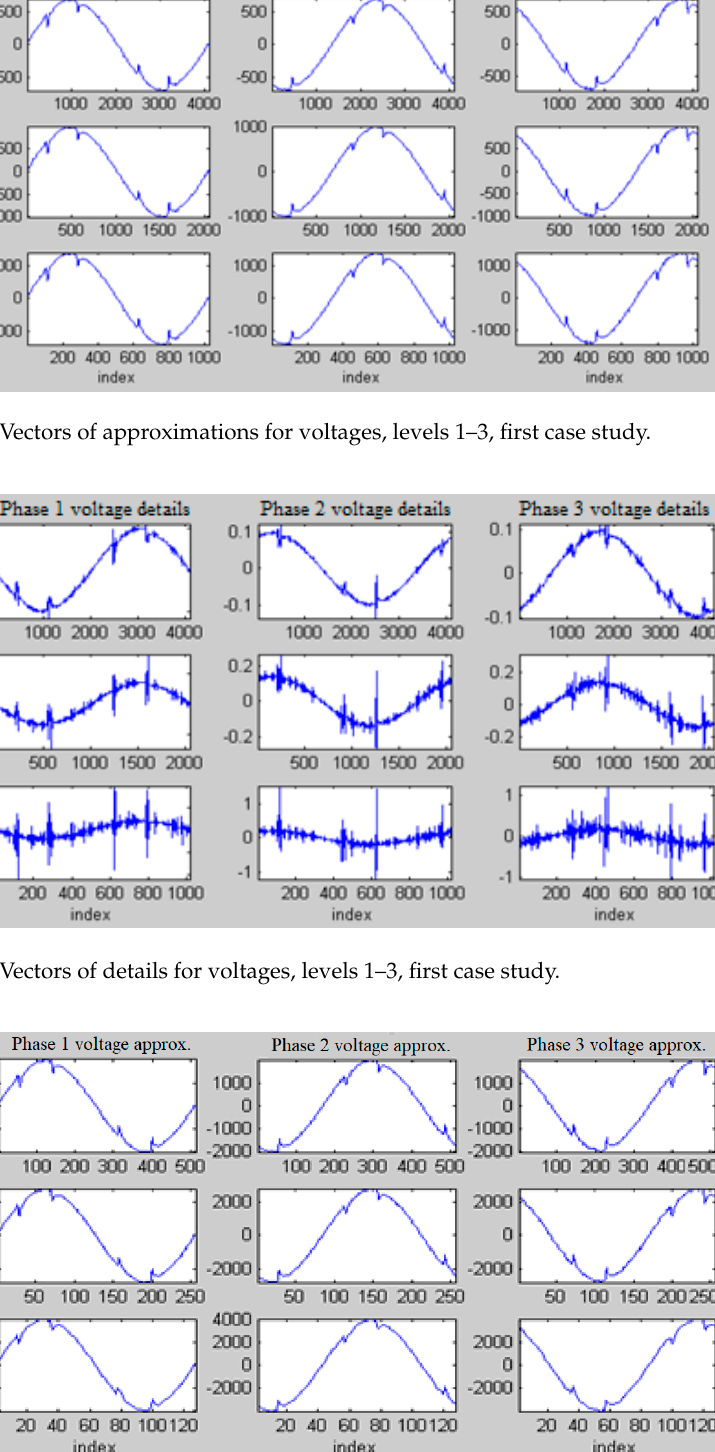
Figure 8. Vectors of approximations for voltages, levels 1–3, first case study. Figure 8. Vectors of approximations for voltages, levels 4–6, first case